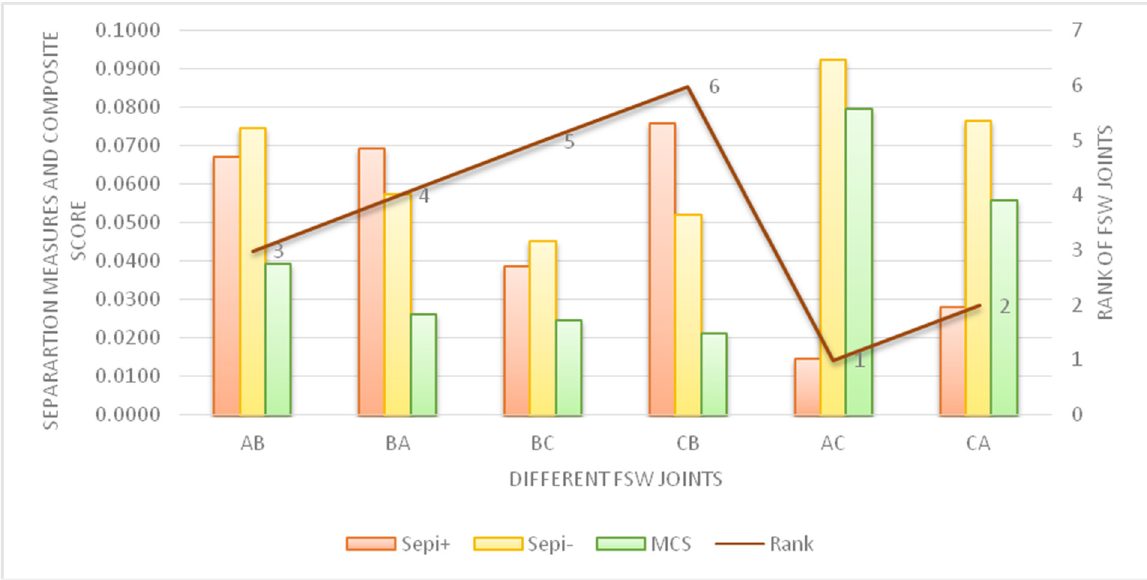
Figure 12. Separation measures, MCS and ranks of AA6061 and AZ31B, AZ31 and AA6061, AZ31B and AZ91, AZ91 and AZ31B, AA6061 and AZ91 and AZ91 and AA6061 FSW